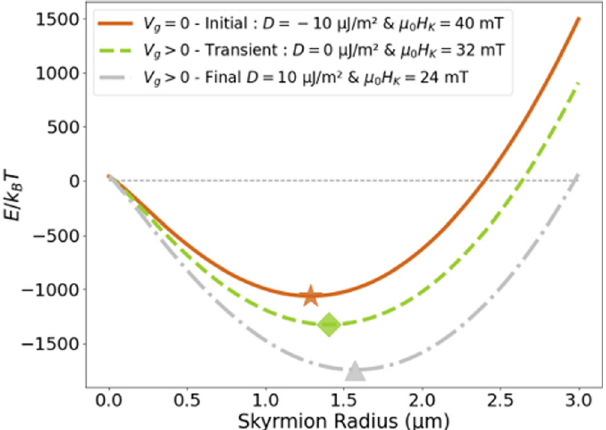
Fig. 3 | Analytical model 34 : stability of skyrmions in FeCoB during iDMI inver- sion induced by the gate voltage. Analytical calculation of energy difference (in units of k B T 300K ) between skyrmion and uniform state for FeCoB as a function of skyrmion radius. Solid orange, dashed green, and dash-dotted gray lines corre- spond, respectively, to negative, zero and positive iDMI, associated with a pro- gressive anisotropy variation under the gate voltage, as experimentally measured. Owing to the small iDMI value in FeCoB, the slight change of equilibrium radius (depicted by symbols) is mostly due to the anisotropy